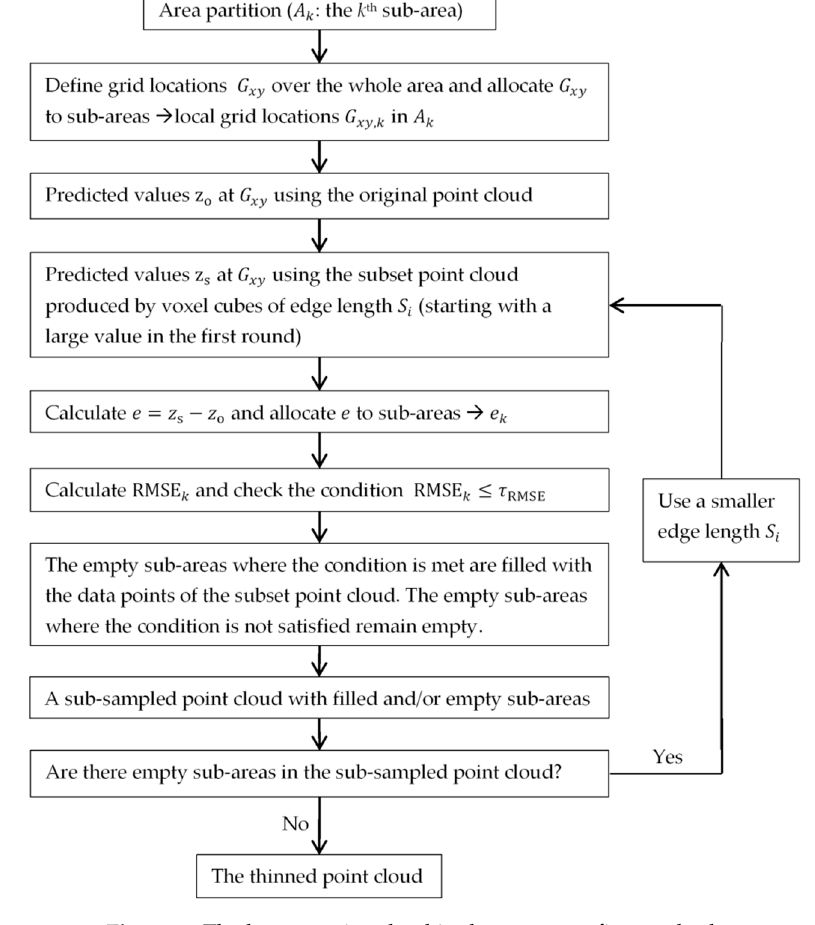
Figure 1. The key steps involved in the coarse-to-fine method.